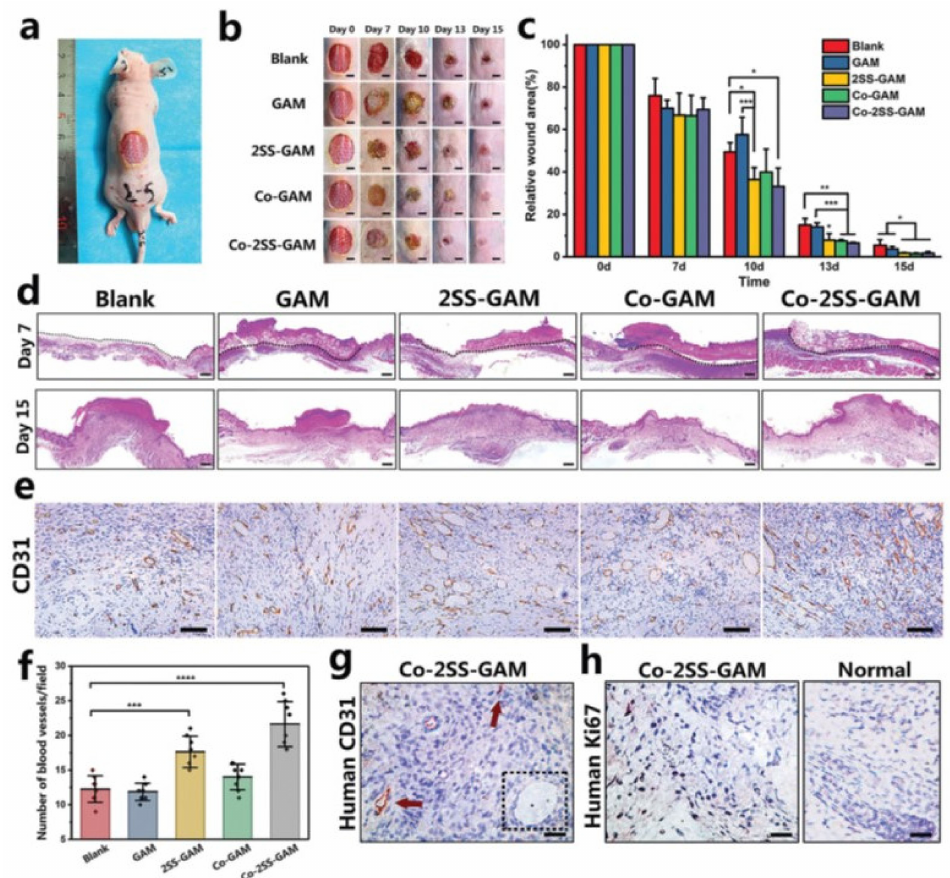
Figure 16. Induction of skin tissue regeneration in nude mice. ( a ) Visual appearance of nude mice after graft of 3D bioprinting scaffolds onto full-thickness skin defects. ( b , c ) Gross photos of murine skin wounds and statistics of wound closure rates of the blank, GAM (cell-free), 2SS-GAM (cell-free), Co-GAM (cell-laden), and Co-2SS-GAM (cell-laden) groups on days 0, 7, 10, 13, and 15 ( n = 4). Scale bar: 5 mm. ( d ) H&E staining of sections of skin tissue obtained from all groups on day 7 and day 15. The black dotted line marked the boundary between the wound and scaffolds on day 7. Scale bar: 500 µ m. ( e ) Images of CD31 immunohistochemical staining exhibited denser blood vessels in SS-containing groups (2SS-GAM and Co-2SS-GAM) than in the other groups. The Co-2SS-GAM group showed the highest degree of angiogenesis. Scale bar: 100 µ m. ( f ) Quantification of blood vessels in the regenerative dermis on day 15 ( n = 8). ( g ) Immunohistochemical staining of specific human CD31 confirmed a few human blood vessels (red arrows) formed by the transplanted HUVECs in Co-2SS-GAM group. The black dotted frame marked the host blood vessel. Scale bar: 30 µ m. ( h ) The activity of the printed cells in Co-2SS-GAM group was shown by human Ki67 antibody staining (brown: human Ki67 and blue: mouse nucleus). Scale bar: 30 µ m. * p < 0.05, ** p < 0.01, *** p < 0.001, **** p < 0.0001. Reproduced from [245] with permission from John Wiley and Sons,